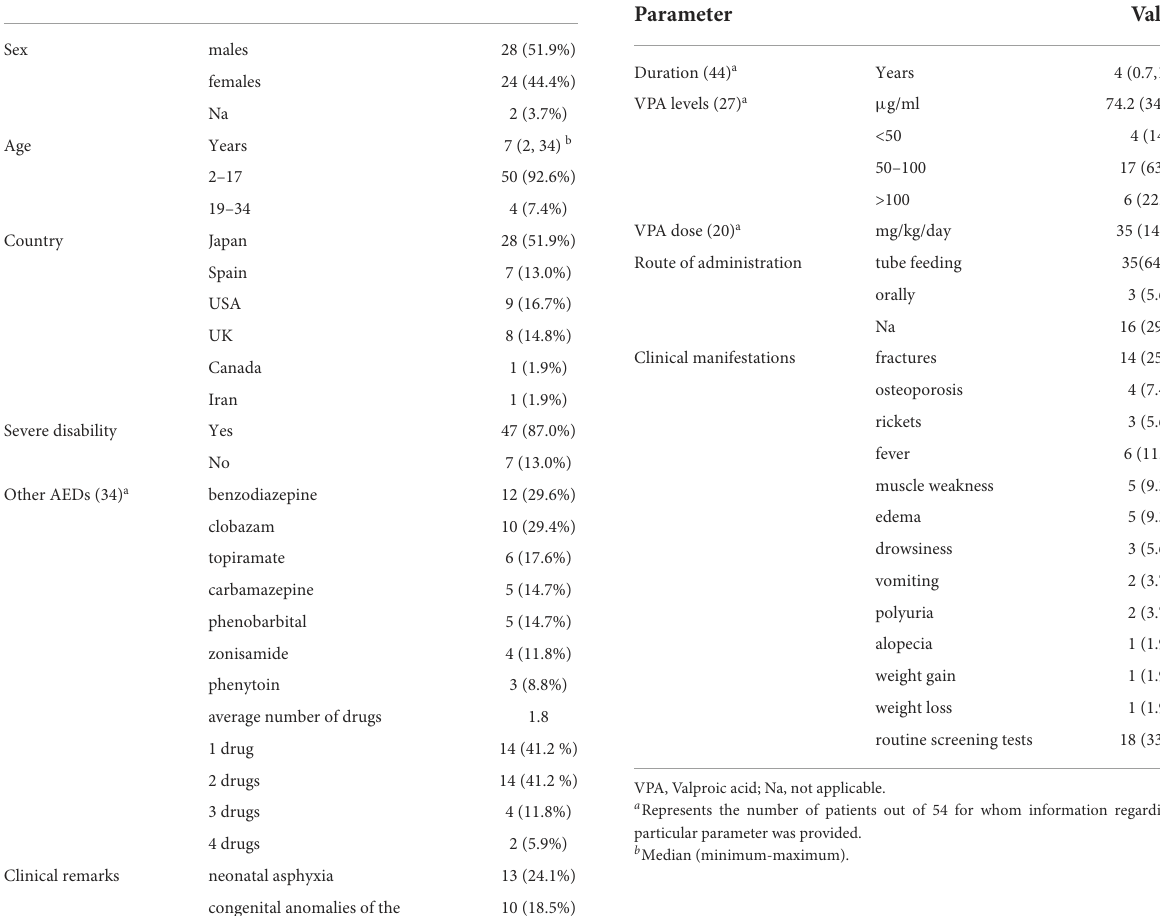
TABLE 1 Basic information of the 54 patients included. TABLE 2 Clinical characteristics and administration of valproate in the 54 included